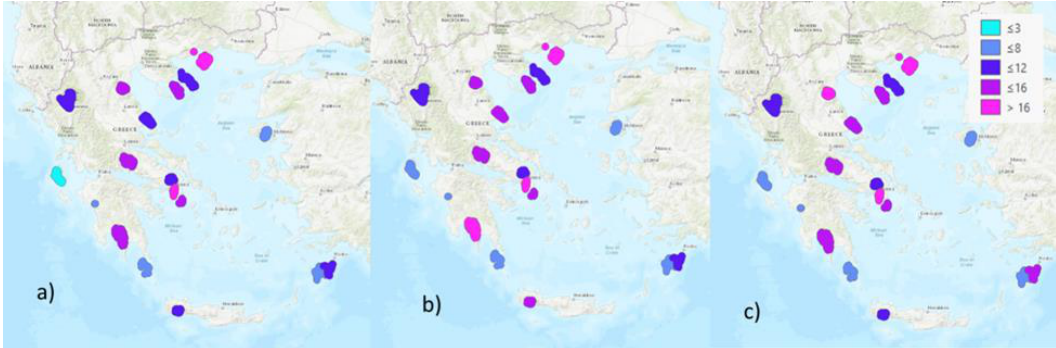
Figure 7. Maps of coloured Areas of Interest (AoI) depicting classified Seasonal Severity Rating (SSR) Mean values, for: ( a ) the historic period, ( b ) RCP 4.5 2036–2045, ( c ) RCP 8.5 2036–2045.